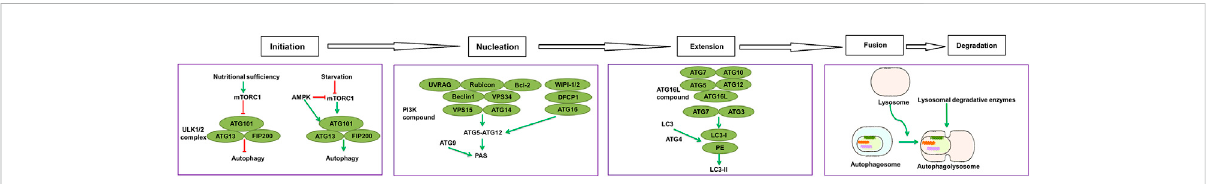
FIGURE 2 List of molecular entities involved in autophagy. ATGs-regulated autophagy system is divided into fi ve stages: initiation, nucleation, expansion, fusion, and